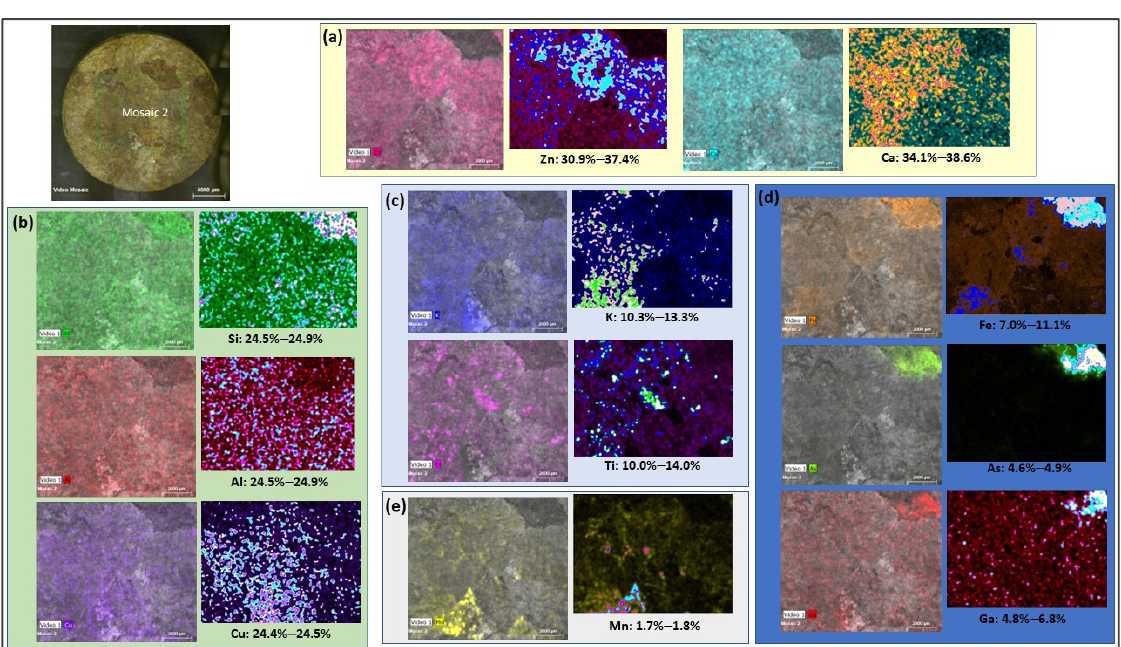
Figure 8. Image 2D micrometric maps of the elements (a) Zn, Ca (b) Si, Al, Cu (c) K, Ti (d) Fe, As, Ga (e) Mn in sample SD1, grain-size fraction “ ≥ 2 mm to <3 mm”, and correspondent maximum estimated percentages of occurrence area (%).